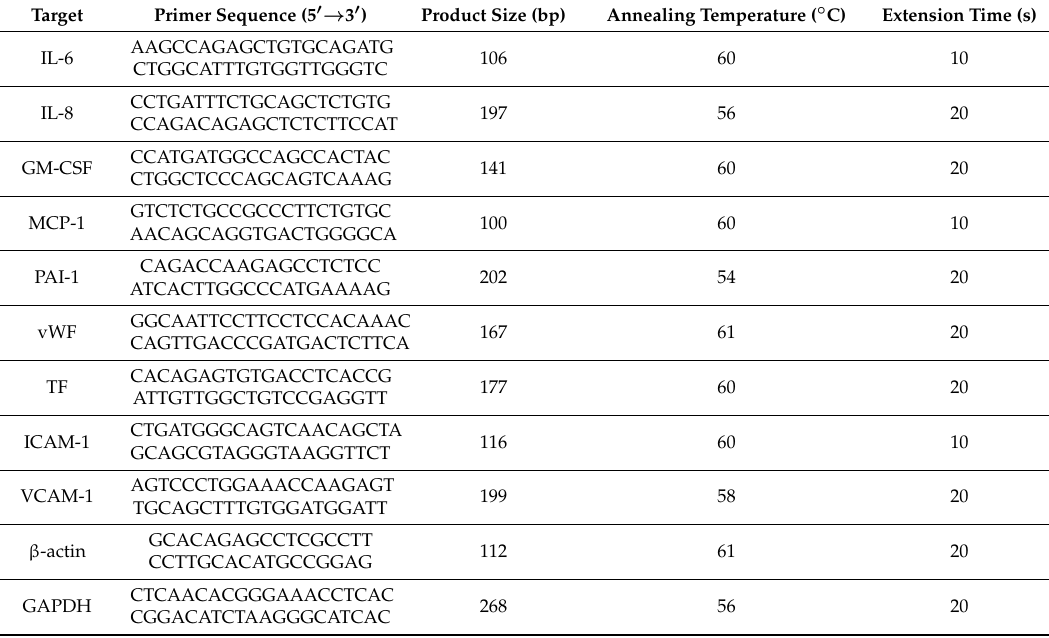
Table 2. Target, primer sequence, product size, annealing temperature (X), and elongation time (Y) used for quantitative real-time